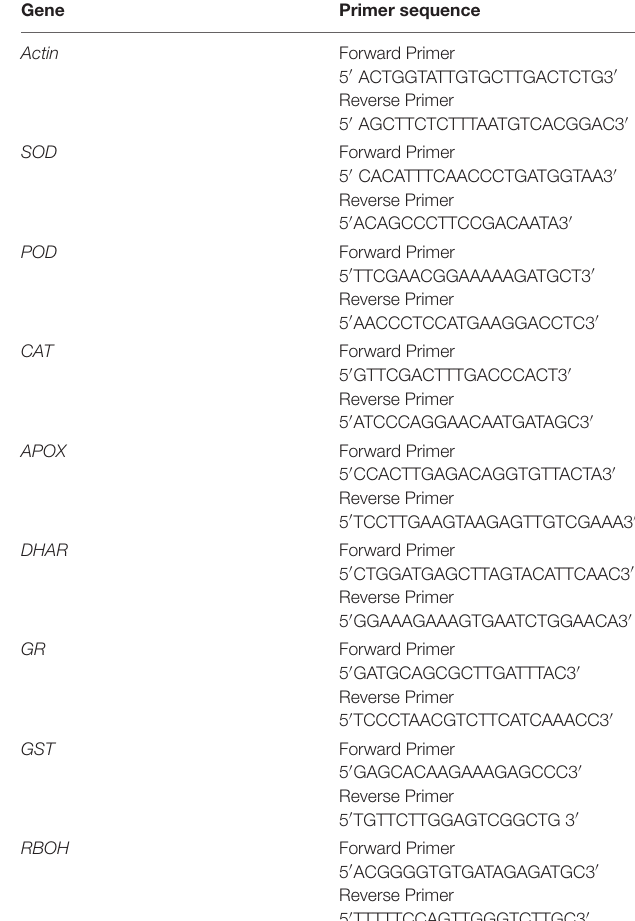
TABLE 1 | Sequences of the gene specific primers for used for